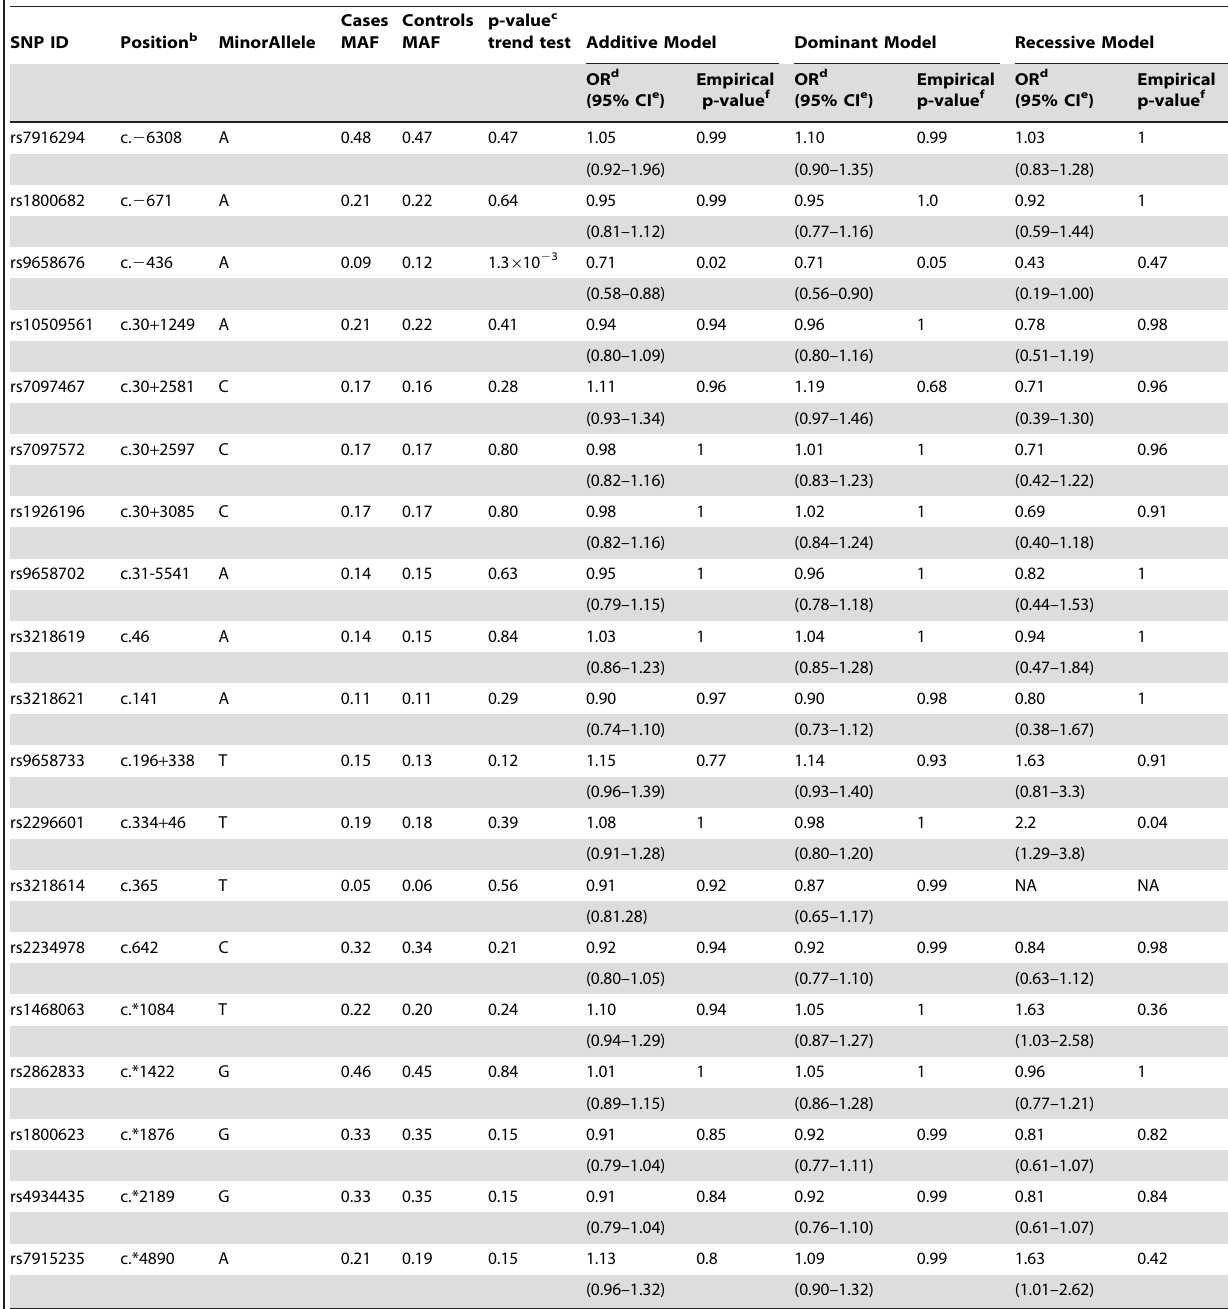
Table 1. Logistic regression results for SNPs of the FAS gene locus a